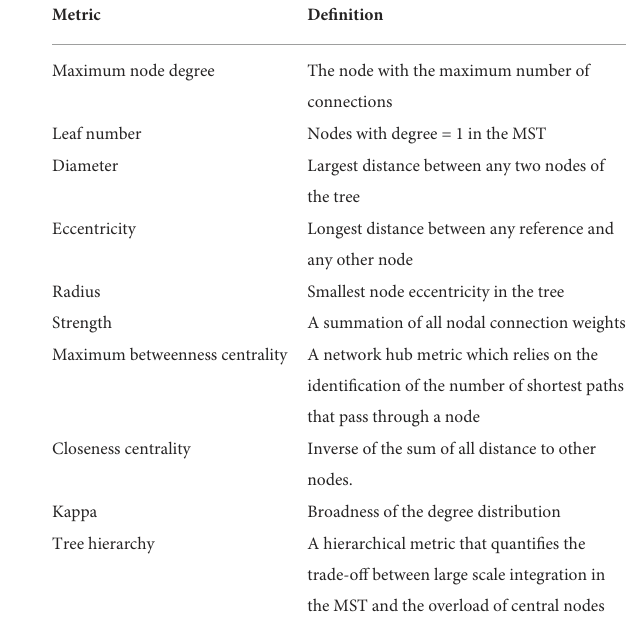
TABLE 2 Graph metrics